Question: Write a single sentence explaining what this figure depicts.
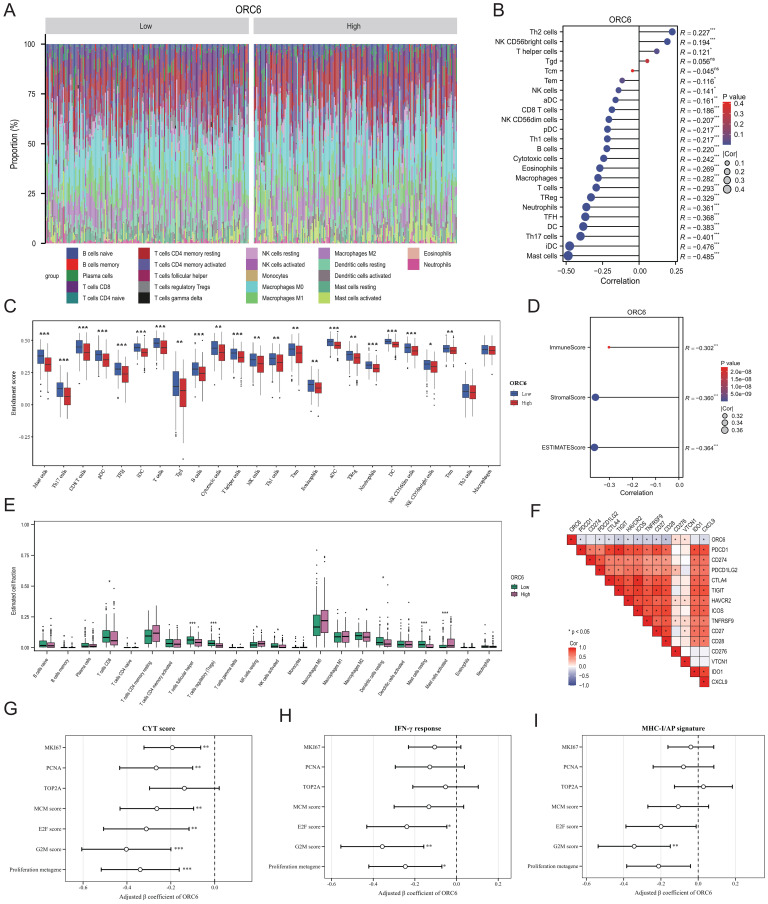
Answer: Inverse association between ORC6 expression and immune-related features in bulk OSCC. (A) CIBERSORT-based overview of the relative proportions of 22 immune cell types in ORC6-low and ORC6-high tumors from the strictly defined TCGA-OSCC cohort. Each bar represents one tumor sample. (B) Spearman correlation analysis between ORC6 expression and ssGSEA-derived immune cell/state scores. Dot color indicates the P value, and dot size indicates the absolute correlation coefficient. (C) Grouped comparison of ssGSEA-derived immune enrichment scores between ORC6-low and ORC6-high tumors. (D) Spearman correlation analysis between ORC6 expression and ESTIMATE-derived ImmuneScore, StromalScore, and ESTIMATEScore. Dot color indicates the P value, and dot size indicates the absolute correlation coefficient. (E) Grouped comparison of CIBERSORT-estimated immune cell fractions between ORC6-low and ORC6-high tumors. (F) Correlation heatmap showing the association between ORC6 and selected immune checkpoint or immunoregulatory genes. (G–I) Proliferation-adjusted associations between ORC6 expression and three representative immune-related features, including CYT score (G) , IFN-γ response (H) , and MHC-I/antigen-presentation signature (I) . Adjusted β coefficients of ORC6 were extracted from multivariable linear models adjusted separately for MKI67, PCNA, TOP2A, MCM score, E2F score, G2M score, or the proliferation metagene. Asterisks indicate statistical significance. *p<0.05.